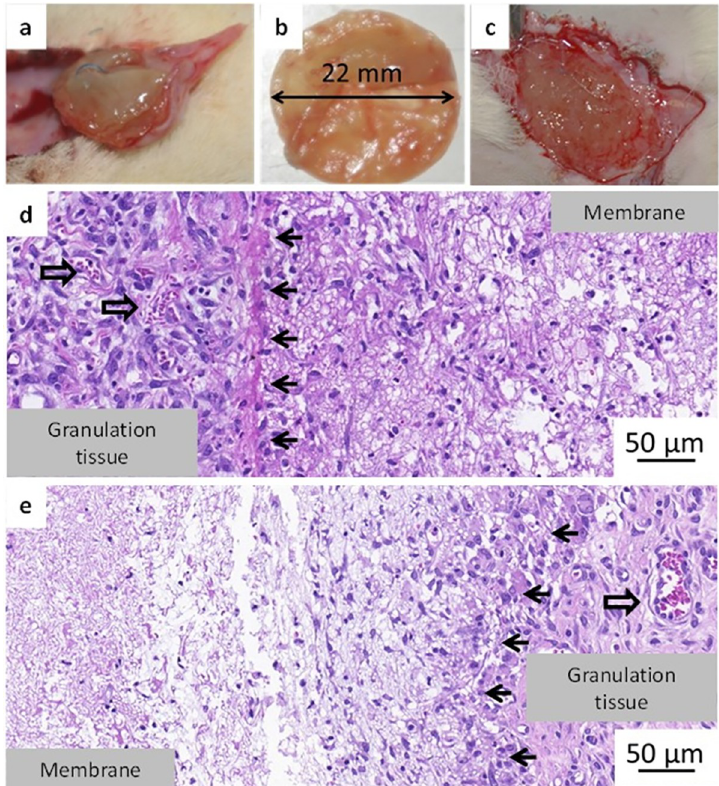
Fig 7. PASPDAB sample 3 days after implantation (a), resected sample grew in size and changed consistency (b), 7 days after implantation (c); representation of histopathology of a sample at day 3 (d) and day 7 (e); Black arrows indicate the boundary between the sample and the tissue and empty black arrows indicate blood